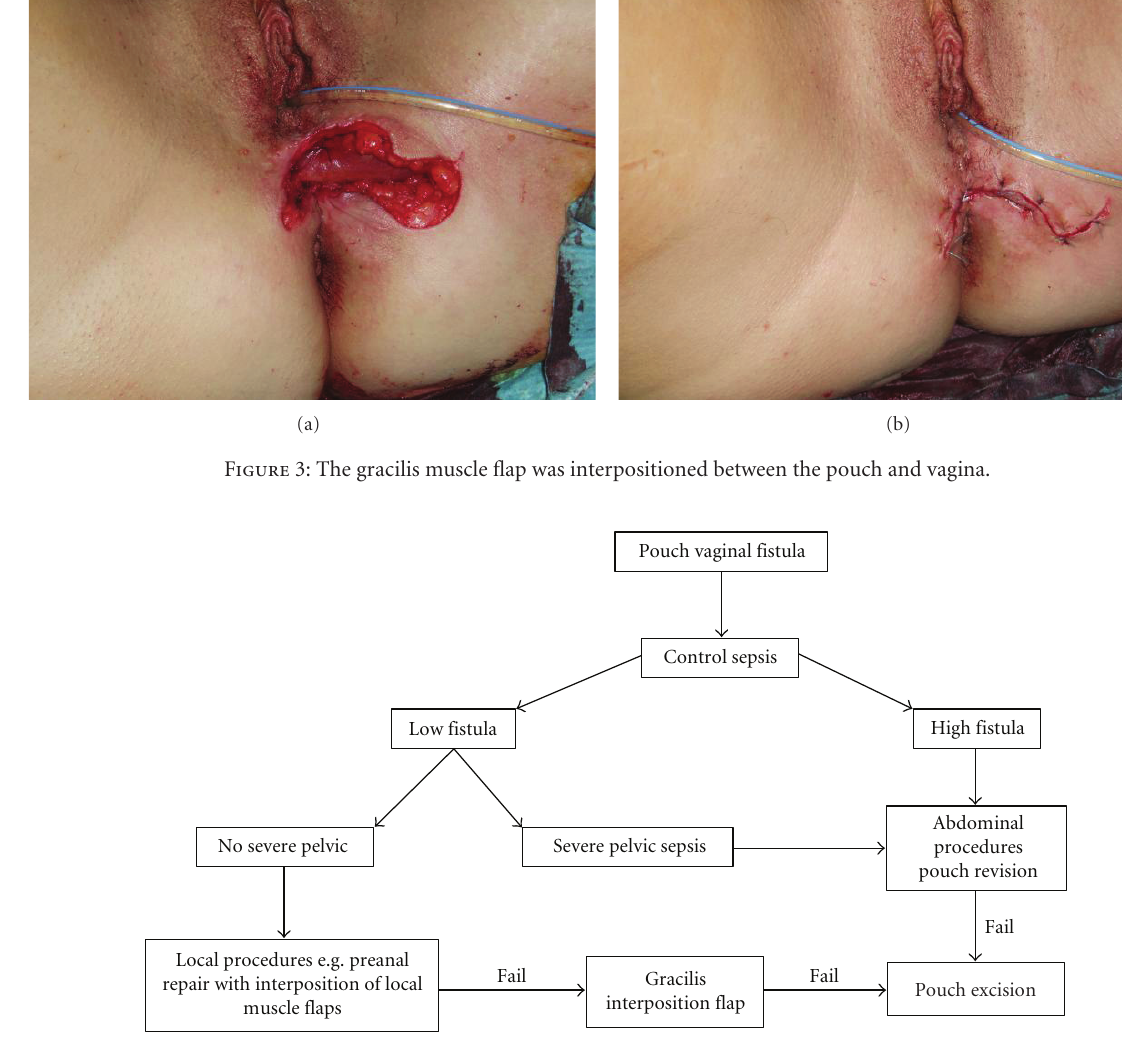
Figure 4: Suggested algorithm for treatment of recurrent PVF: in the case of PVF, the first priority is sepsis control (that is if necessary an ileostomy). Next the type of fistula, high or low should be determined. In the case of a high fistula, an abdominal procedure should be performed. In the case of low fistula the course of therapy depends on the presence or absence of pelvic sepsis. In the case of pelvic sepsis an abdominal procedure should be performed. If there is no severe pelvic sepsis, local procedures should be carried out. These procedures can be repeated. In the case of recurrence, gracilis interposition flap should be performed. Pouch excision should be considered only as the ultimate